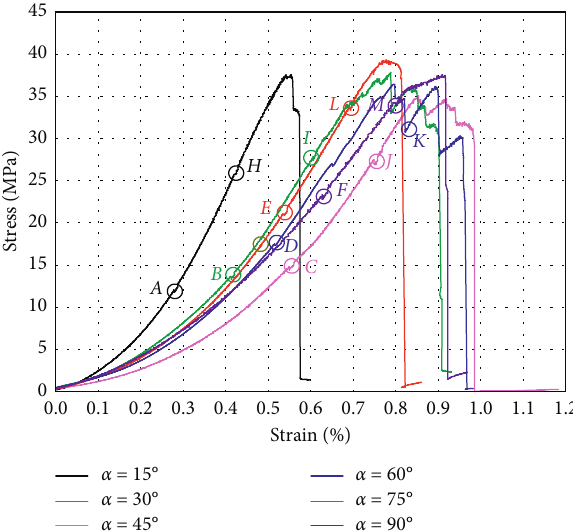
Figure 8: Stress-strain curves with different k . Table 4: Crack initiation and coalescence forces σ for different joint persistency.